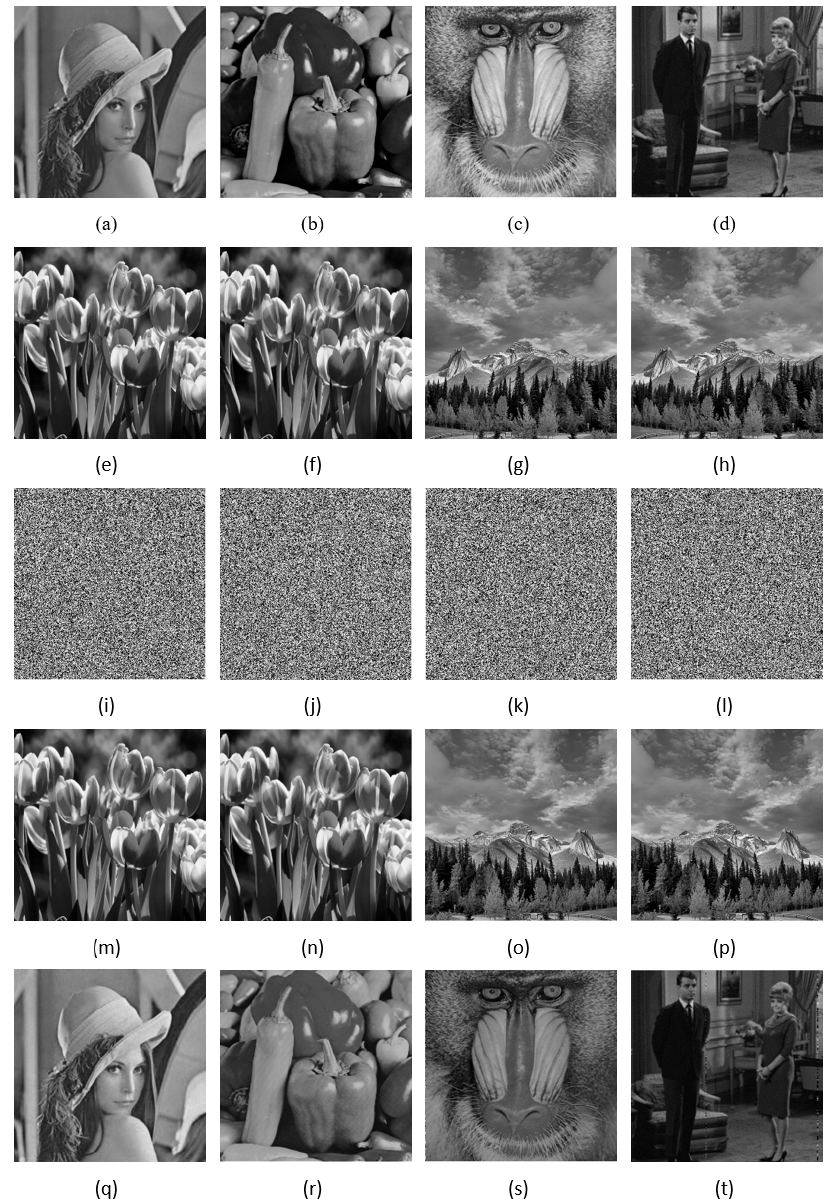
Figure 6. Simulation results. ( a – d ) are the original images, ( e – h ) are the encrypted images, ( i – l ) are the embedded images, ( m – p ) are the embedded images with the encrypted images, ( q – t ) are the decrypted images.